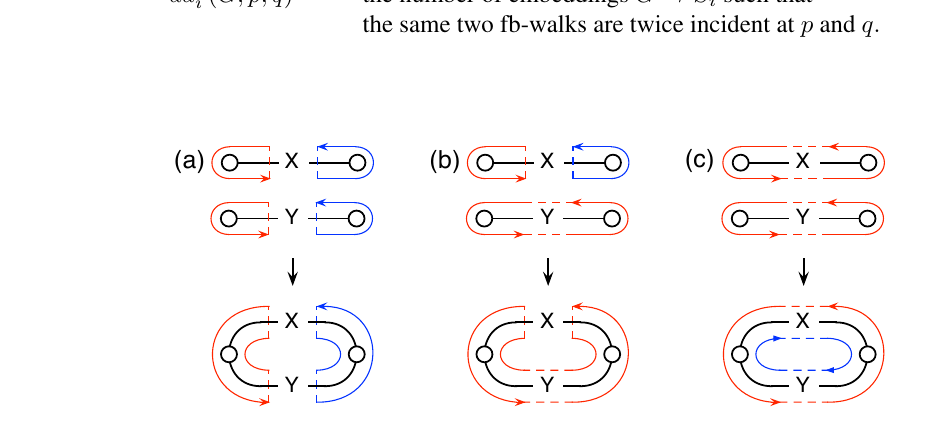
Fig. 10: Parallel operations on two